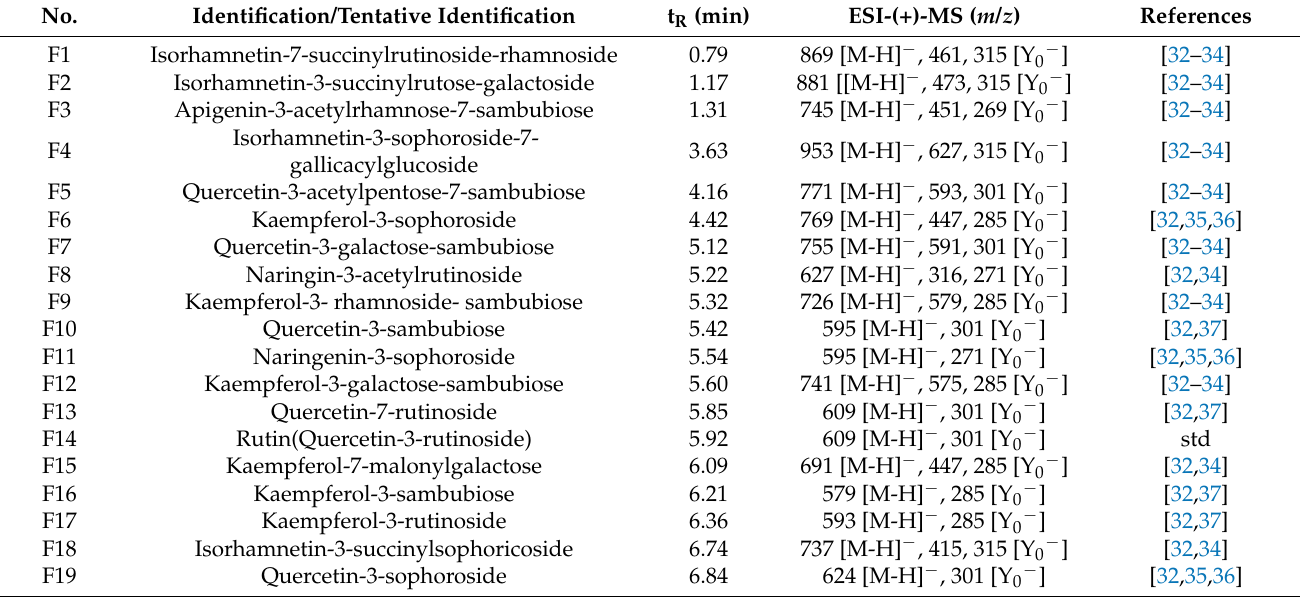
Table 2. Anthoxanthin components in petals of